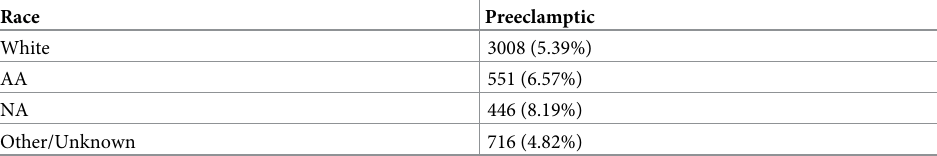
Table 7. Distribution of preeclamptic patients among different race in the Oklahoma PUDF, where AA: African American, NA: Native American.